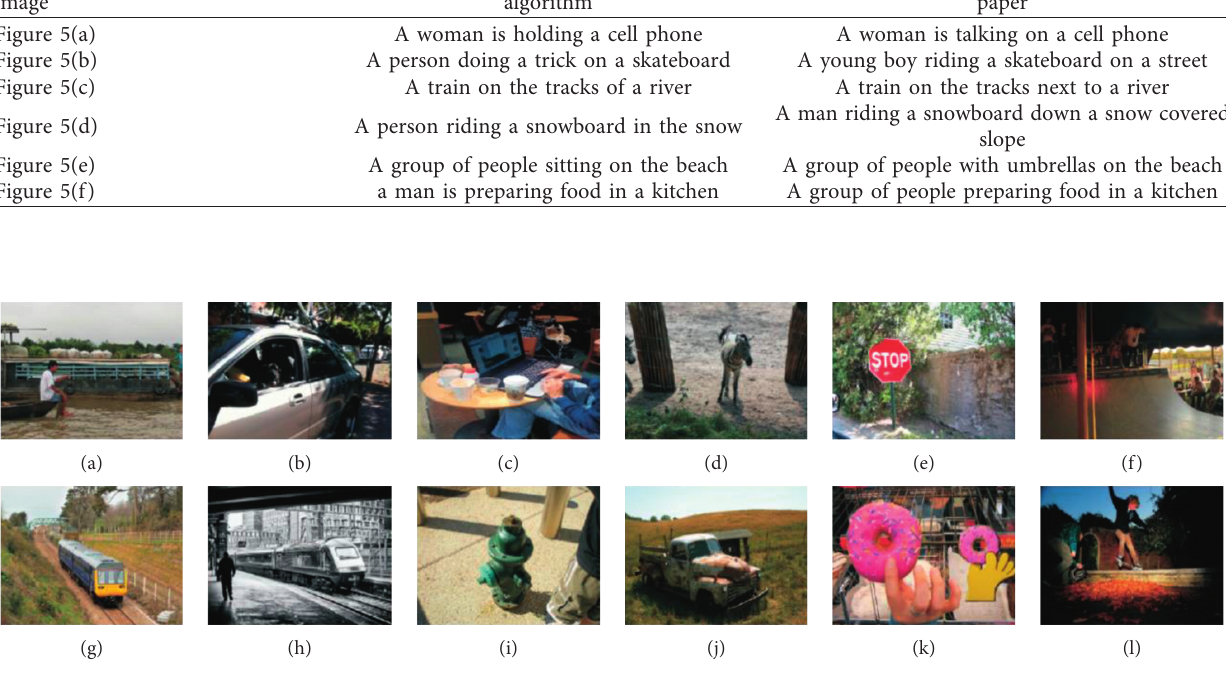
Table 4: Comparison of the description details between the algorithm put forward in this paper and the single attention algorithm. Serial number of the multimedia